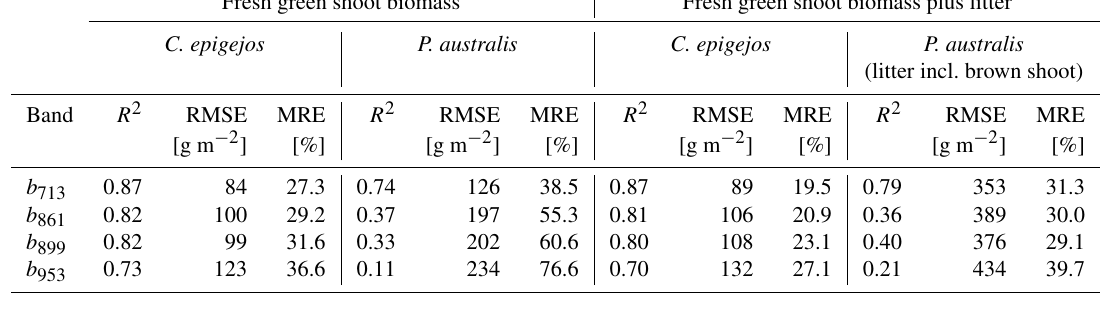
Table 3. R 2 , RMSE and MRE for relationships between examined NDVIs and aboveground biomass of C. epigejos and P. australis . Fresh green shoot biomass